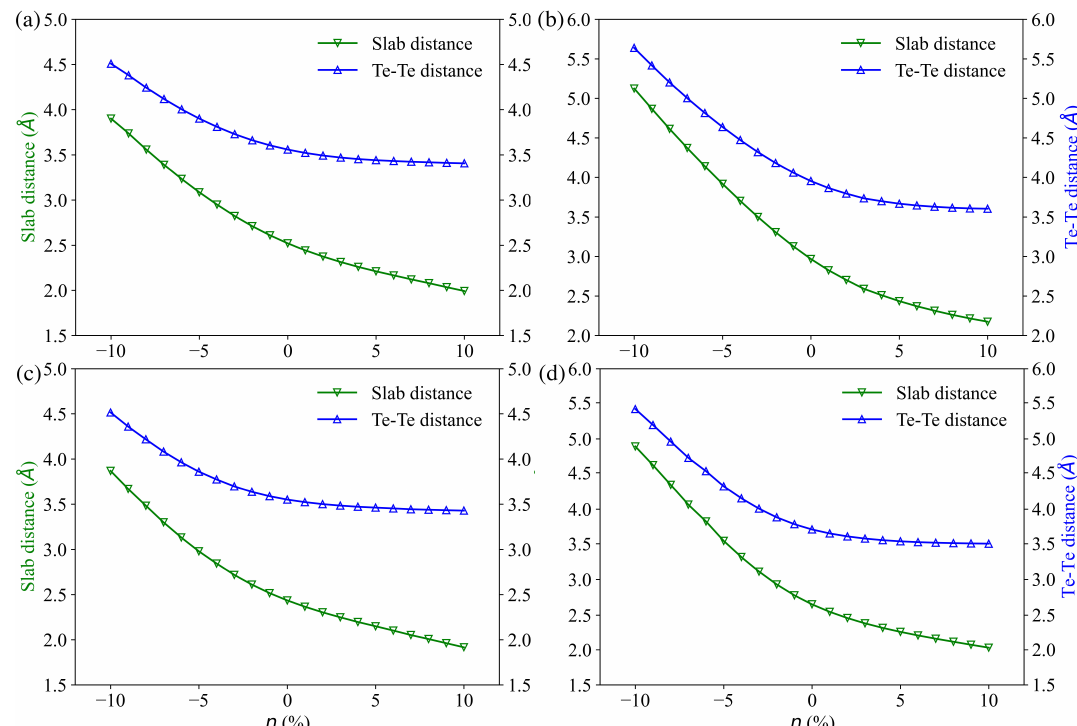
Figure 2. Gap distance between multi-layer slab (green lines) and Te–Te distance between adjacent slabs (blue lines) versus strain for Bi 2 Te 3 ( a ), PbBi 2 Te 4 ( b ), PbBi 4 Te 7 ( c ) and Pb 2 Bi 2 Te 5 ( d ).